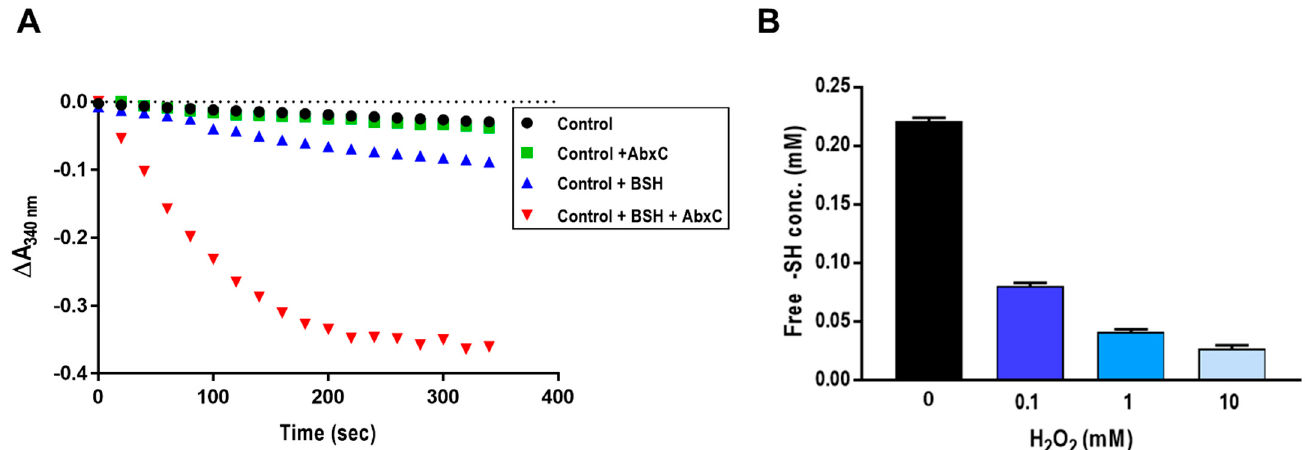
Figure 4. AbxC oxidation by scavenging H 2 O 2 . ( A ) NADPH consumption by the DrBdr/BSH/AbxC pathway. The control reaction mixture contained 500 µ M NADPH and 0.5 µ M DrBdr (DR_2623), and 500 µ M BSH and/or 10 µ M AbxC were added in the control mixture. The NADPH consumption was monitored at 340 nm immediately after addition of 10 mM H 2 O 2 . The experiments were repeated twice and representative data are shown. ( B ) Evaluation of free thiols (-SH) of AbxC. The purified AbxC (0.1 μ M) treated with 0.1, 1, and 10 mM H 2 O 2 was incubated with 10 mM DTNB solution. The TNB 2 − ions released during these reactions were monitored by visible spectroscopy at 412 nm. The –SH concentrations were quantified by the use of a cysteine standard curve. Data represent the means ± standard deviations of three independent experiments.